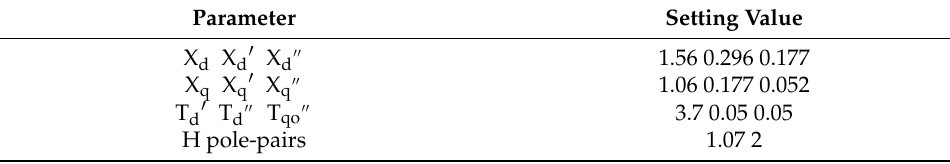
Table A2. Synchronous generator